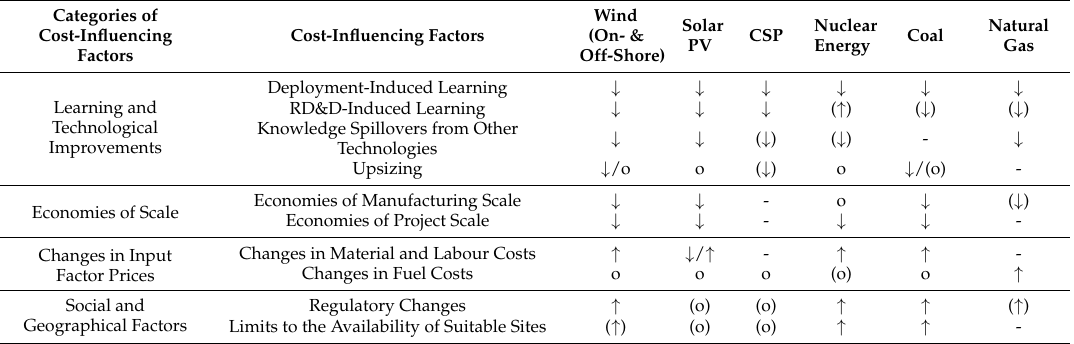
Table 2. Summary of the findings of the literature review on factors influencing past cost developments of electricity generation